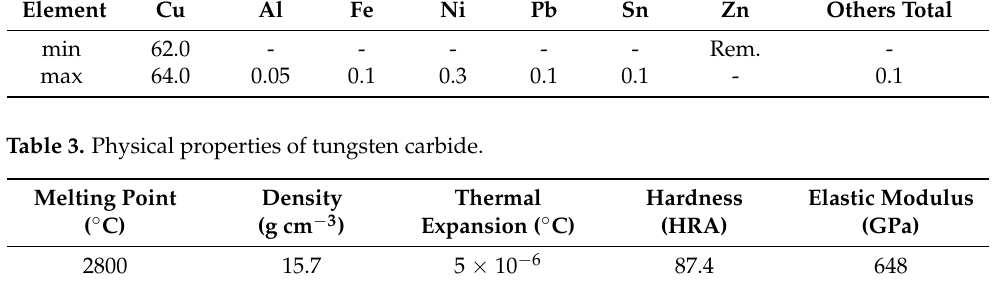
Table 5 . Machining Conditions .